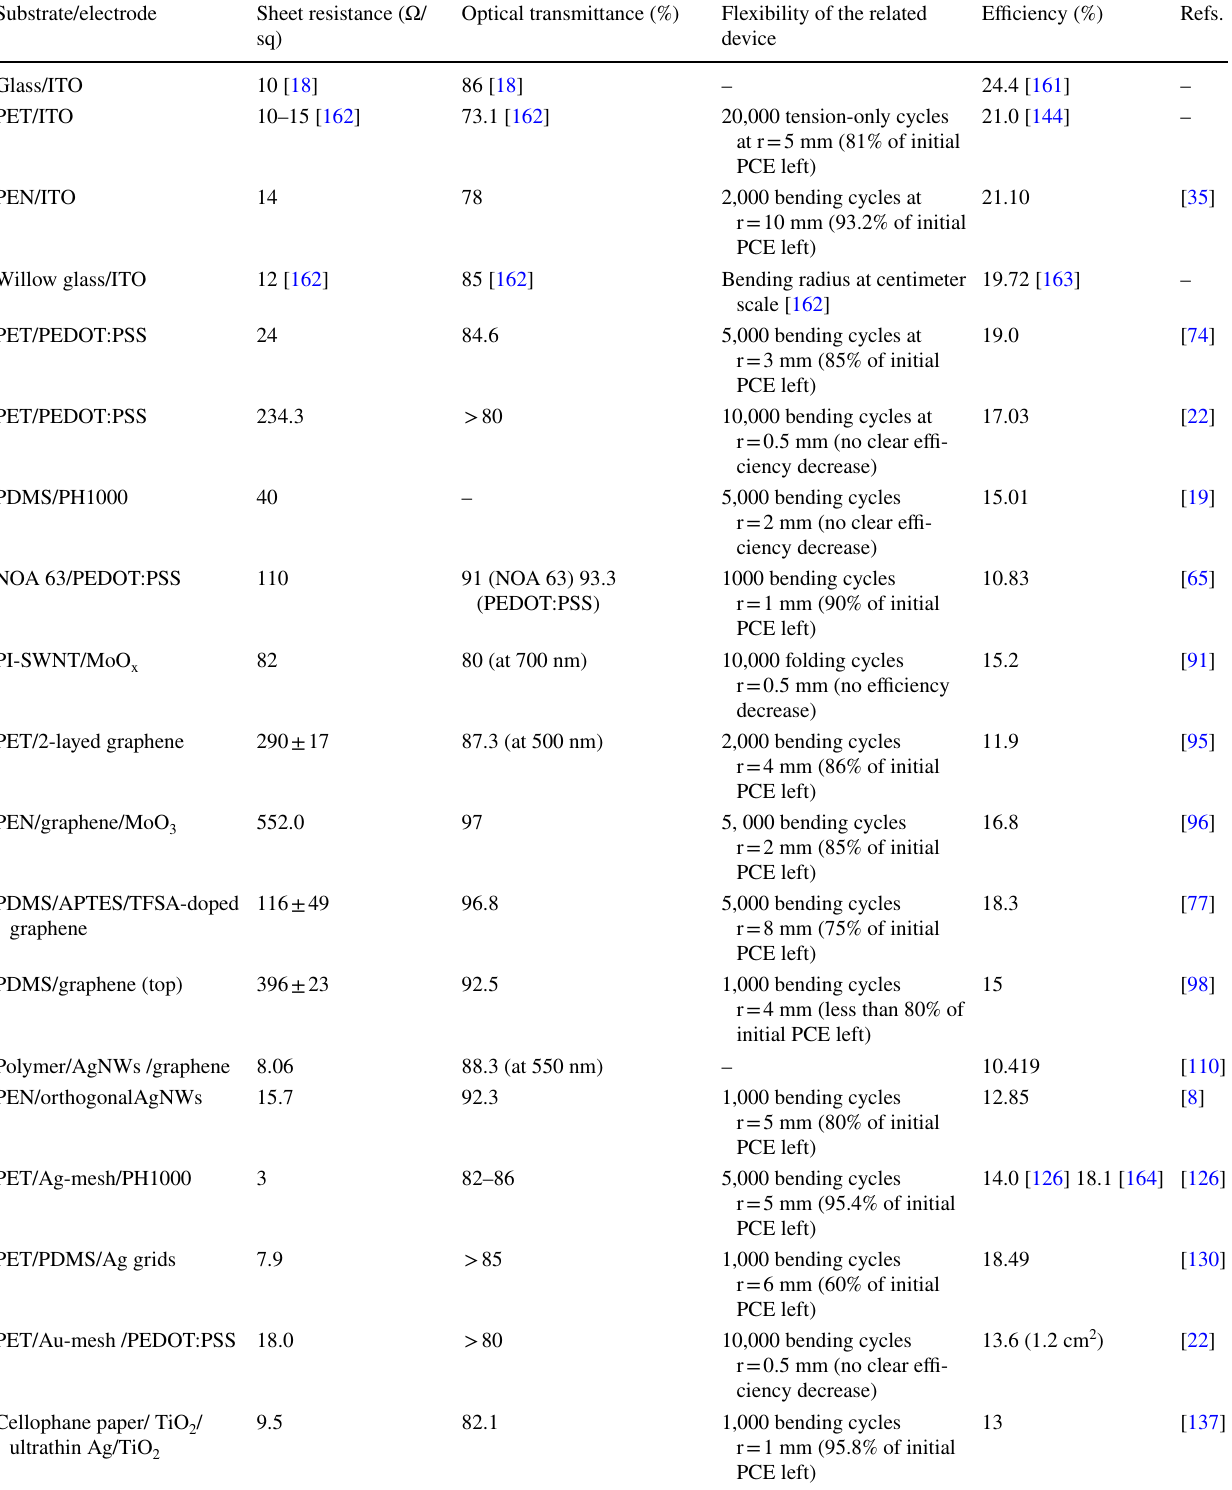
Table 1 Summary of flexible transparent electrodes Substrate/electrode Sheet resistance (Ω/ Optical transmittance (%) Flexibility of the related Efficiency (%) sq) device